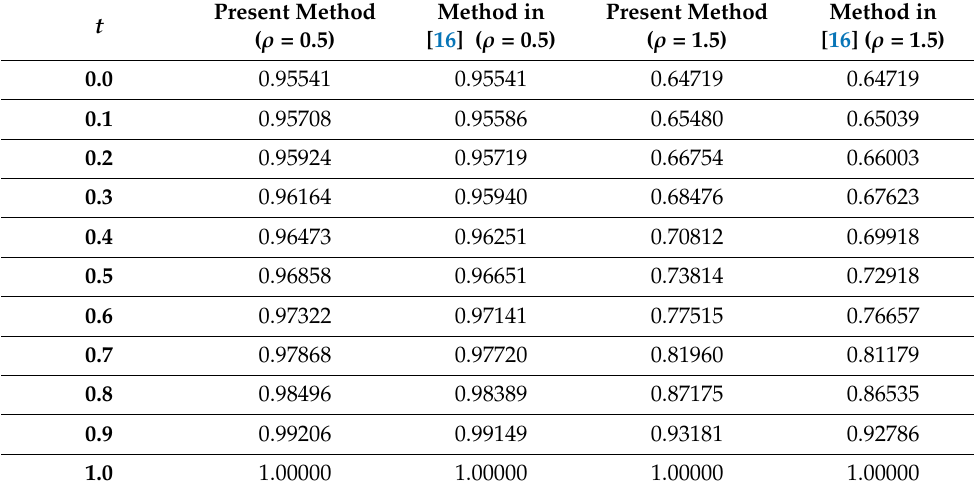
Table 2. Comparison of the results with different values of the parameter ρ .